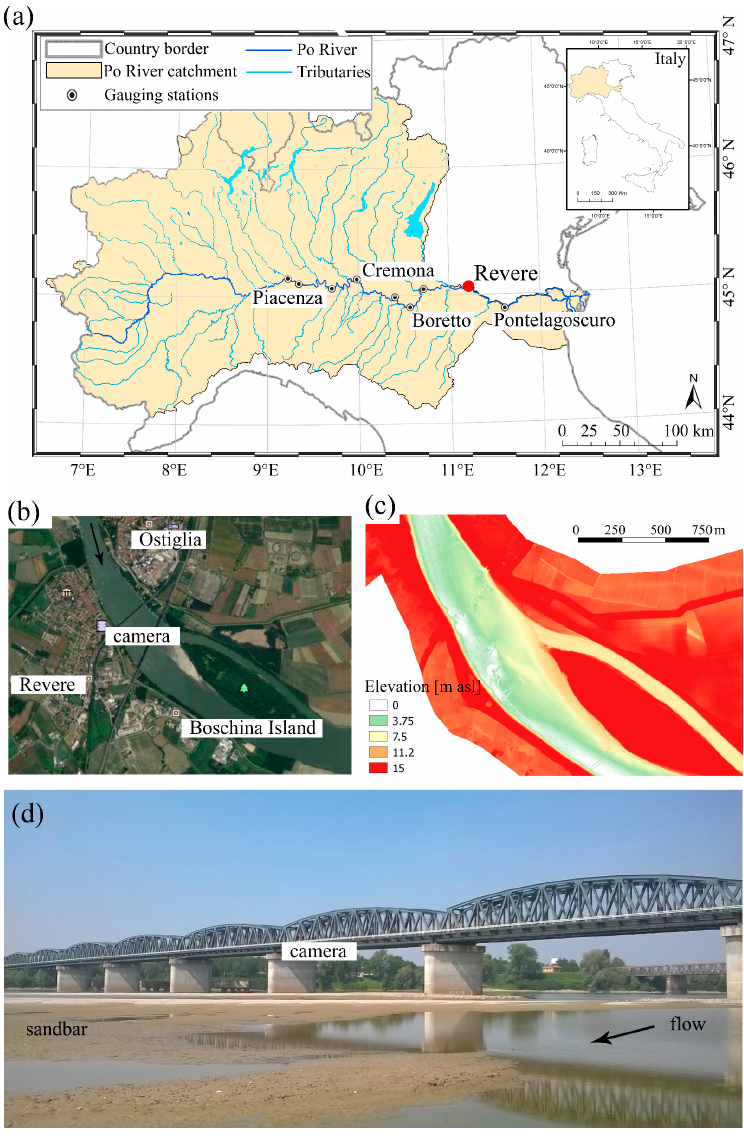
Figure 1. Study site: ( a ) Po River catchment; ( b ) satellite image; ( c ) digital elevation model of the studied reach close to the city of Revere; ( d ) location of the camera on the railway bridge crossing the Po River at Revere (sight from